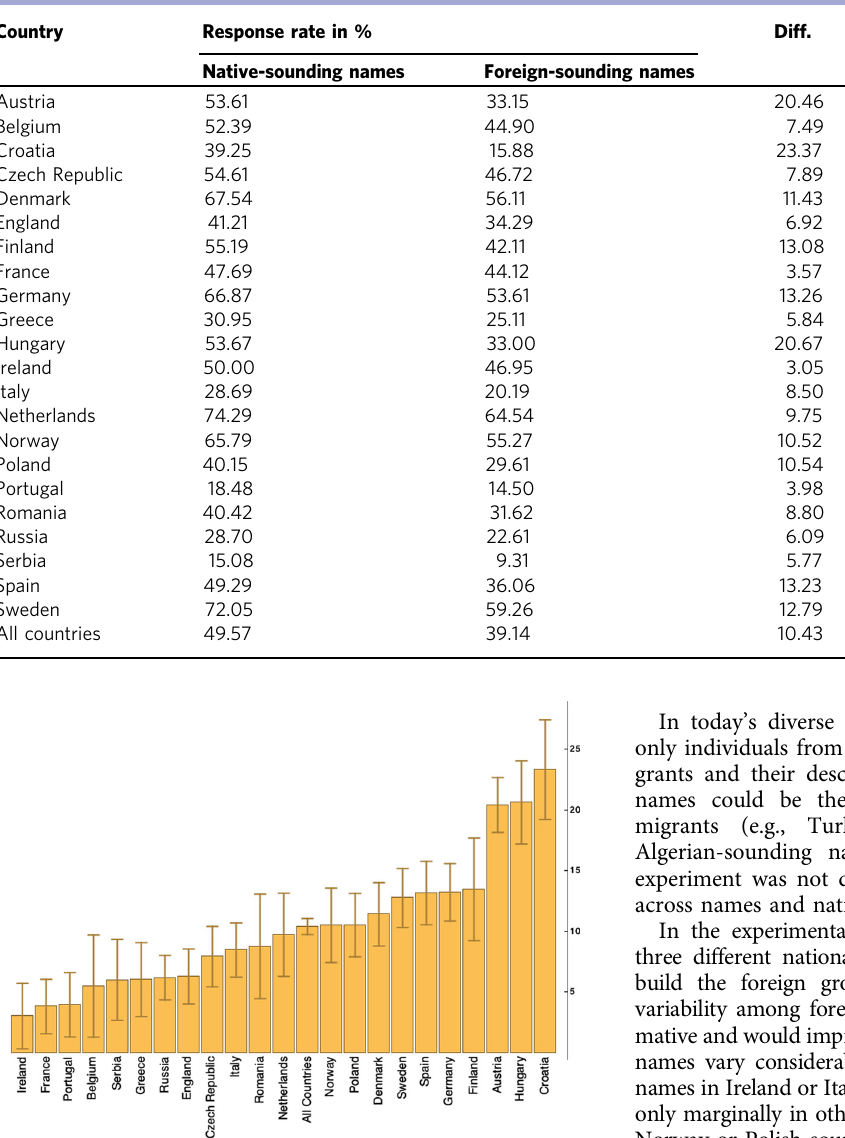
Fig. 3 Response rate difference between foreign-sounding and native- sounding